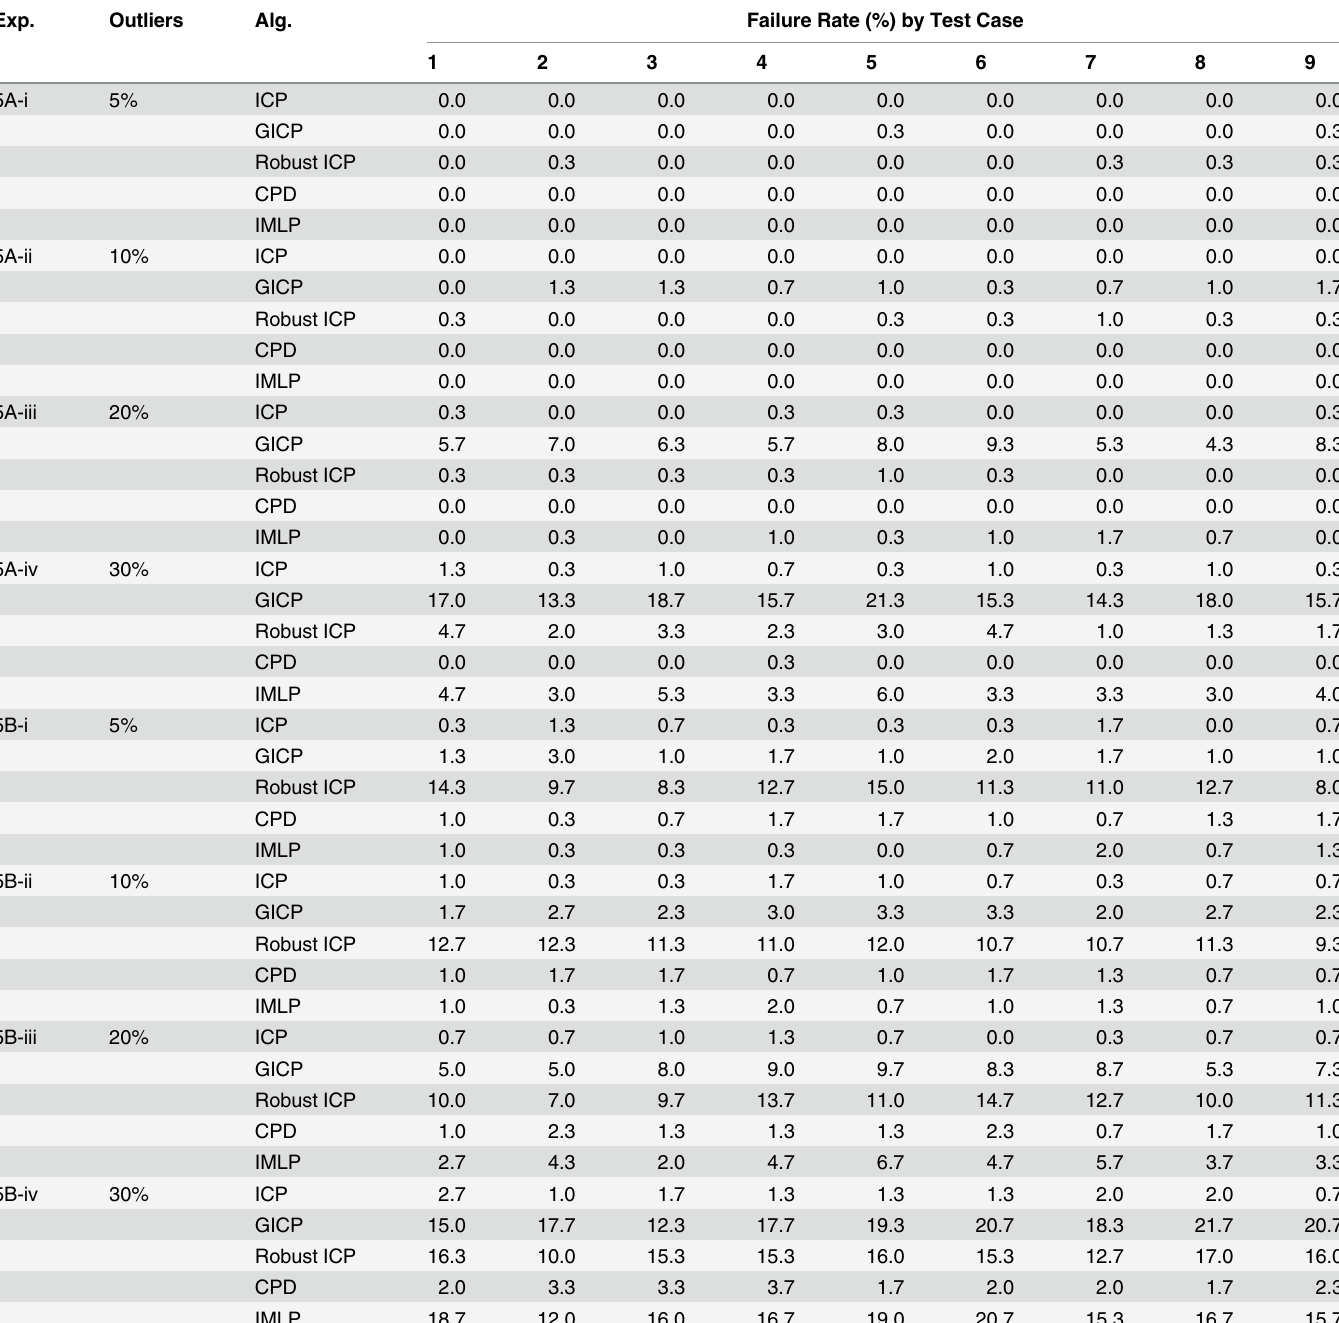
Table 10. Registration failure rates for registering a point-cloud target shape with outliers. (Experiment 5).